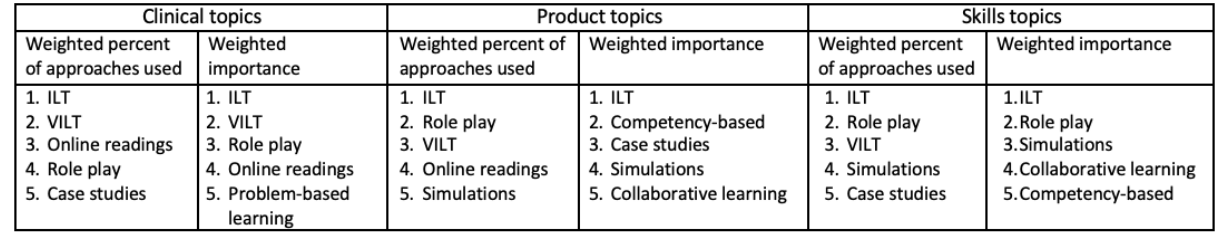
Figure 1. Weighted comparison between pedagogy use and importance in sales. ILT: instructor-led training; VILT: virtual instructor-led training.